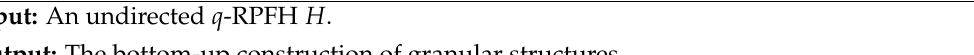
Algorithm 1 The bottom-up